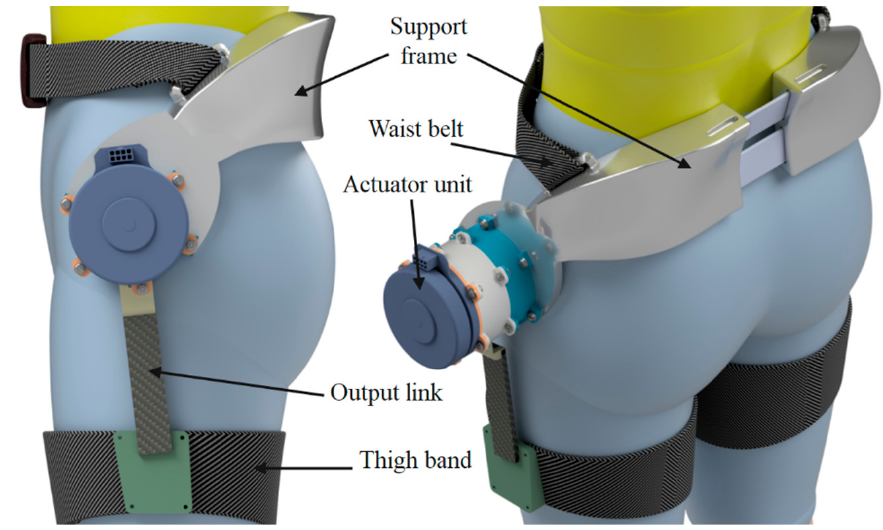
Figure 3. Soft trunk – hip exoskeleton schematic .